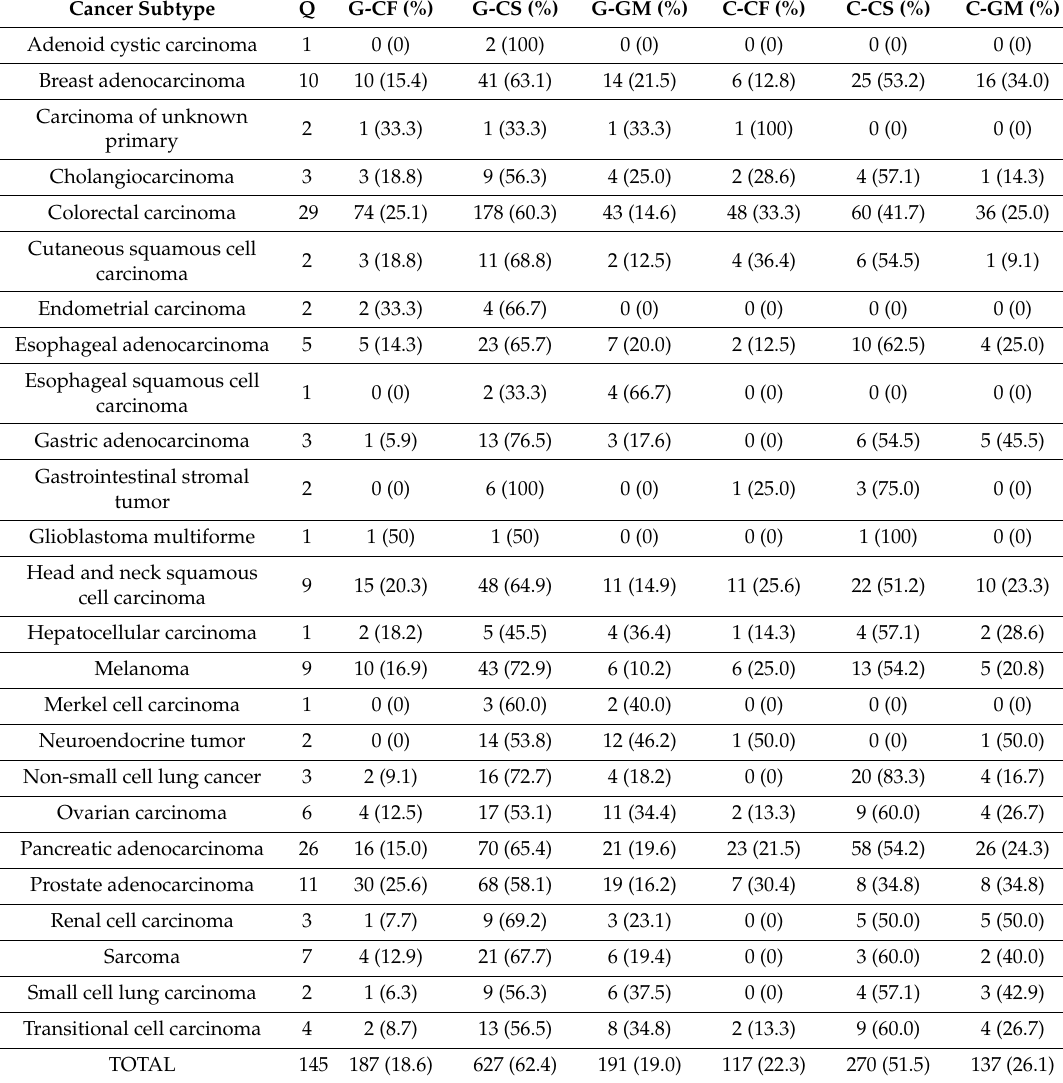
Table 1. Cancer subtypes and sample size that are stratified in cell fate (CF), cell survival (CS), and genome maintenance (GM) by both next generation sequencing platforms, Caris and Guardant360. Raw values represent quantities of gene mutations per category. Values in parentheses represent gene percentages within the sample group. This table shows major trends that drive tumorigenesis with overall trends at the bottom as the total. Gene designations of CF, CS, and GM also displayed for reference. See appendix for